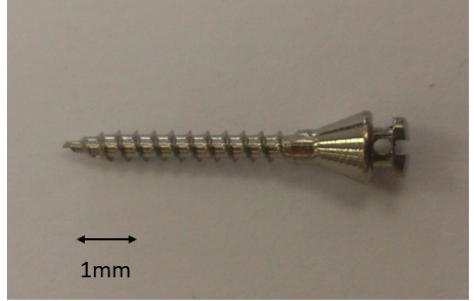
Figure 3. Orthodontic mini-implant used in this study.